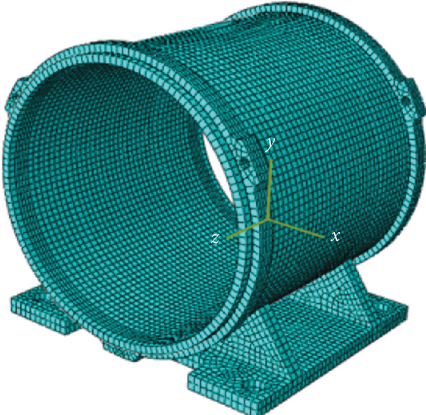
Figure 3: Finite element model of the CFRP Motor